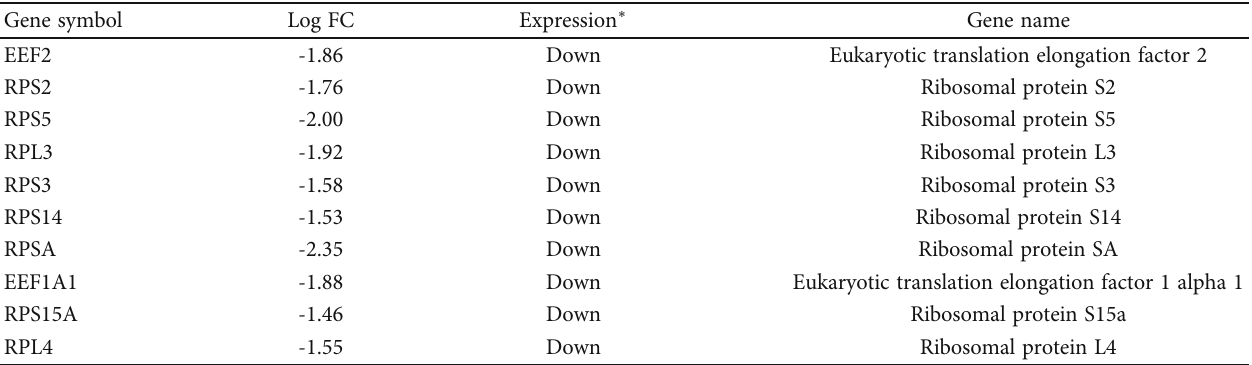
Table 1: Hub genes identi fi ed by the protein-protein interaction (PPI)